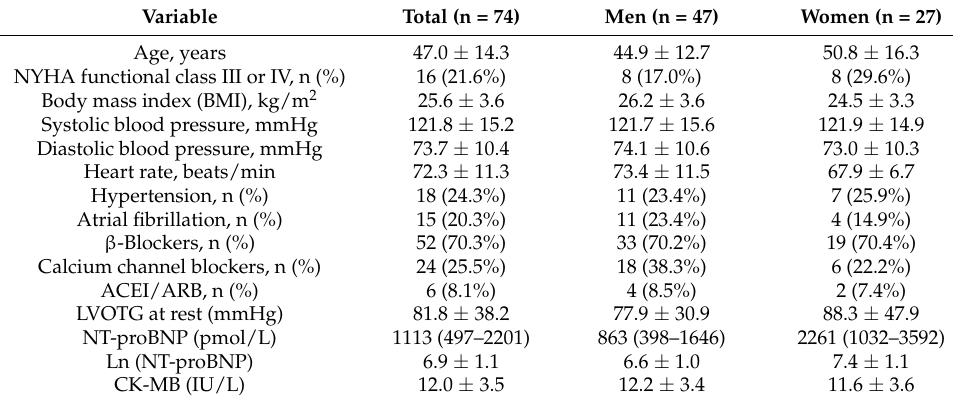
Table 1. Baseline characteristics of patients with hypertrophic